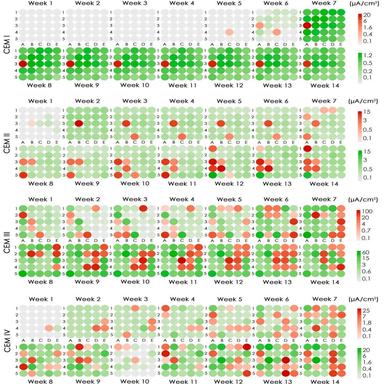
Average corrosion current densities showing the anodic (red) and cathodic (green) reactions for the CEM I, CEM II, CEM III and CEM IV cements, represented in array form. (For interpretation of the references to colour in this figure legend, the reader is referred to the web version of this article.)